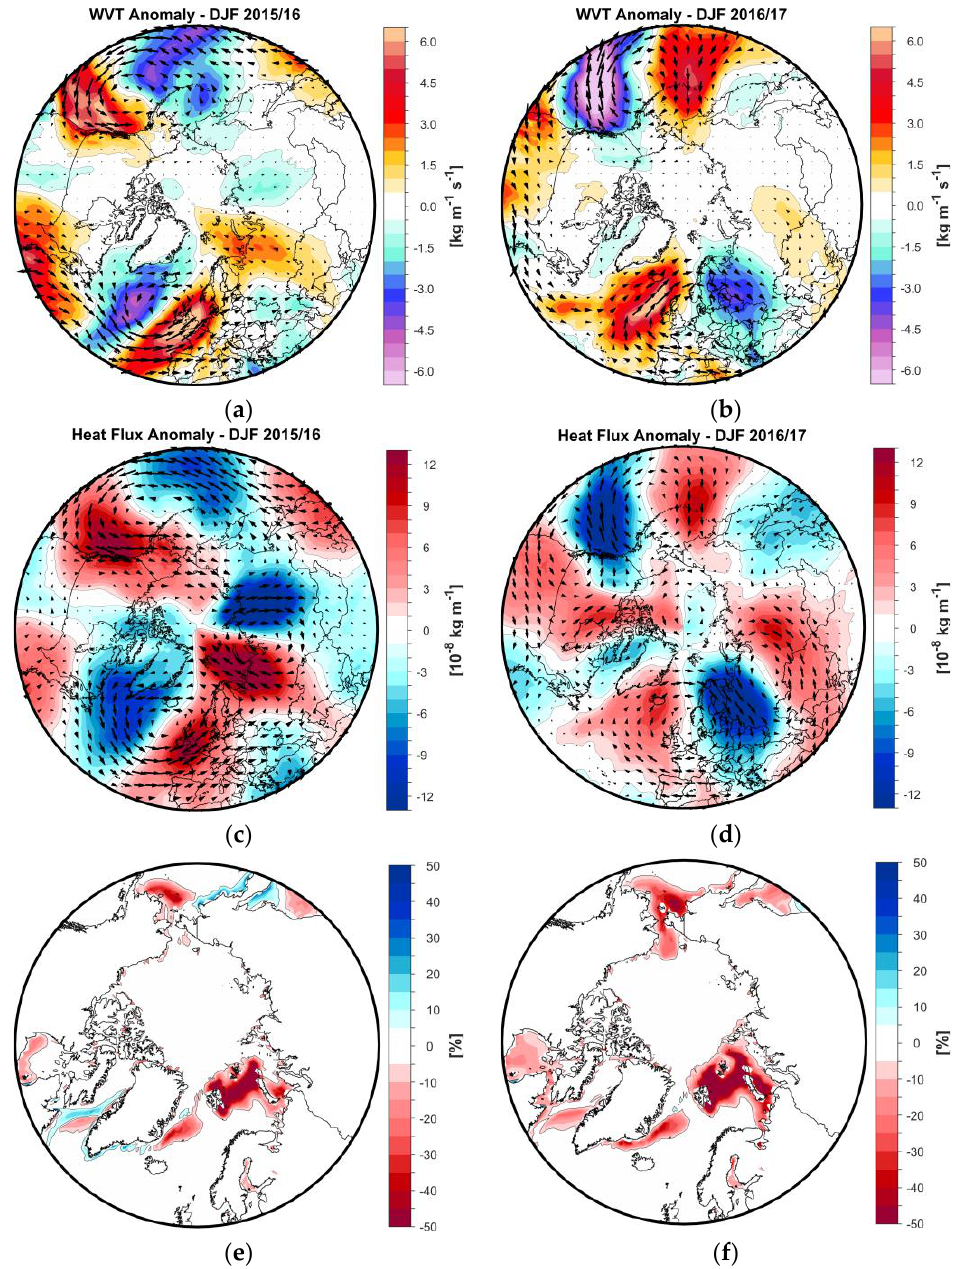
Figure 11. ( a ) The vertical integral of northward water vapor flux (shaded areas) and the vertically integrated water vapor transport (arrows) averaged over winter 2015/16 (December 2015, January 2016, and February 2016); ( b ) as in (a) but for winter 2016/17; ( c ) the vertical integral of northward heat flux (shaded areas) and the vertically integrated heat transport (arrows) averaged over winter 2015/16 (December 2015, January 2016, and February 2016); ( d ) as in ( a ) but for winter 2016/17; ( e ) sea ice concentration (SIC) anomalies for winter 2015/16; ( f ) as in ( e ) but for winter 2016/17. The anomalies are computed relative to the reference period 1981 – 2000. In ( a – d ), positive anomalies indicate northward advection and negative anomalies indicate southward advection.